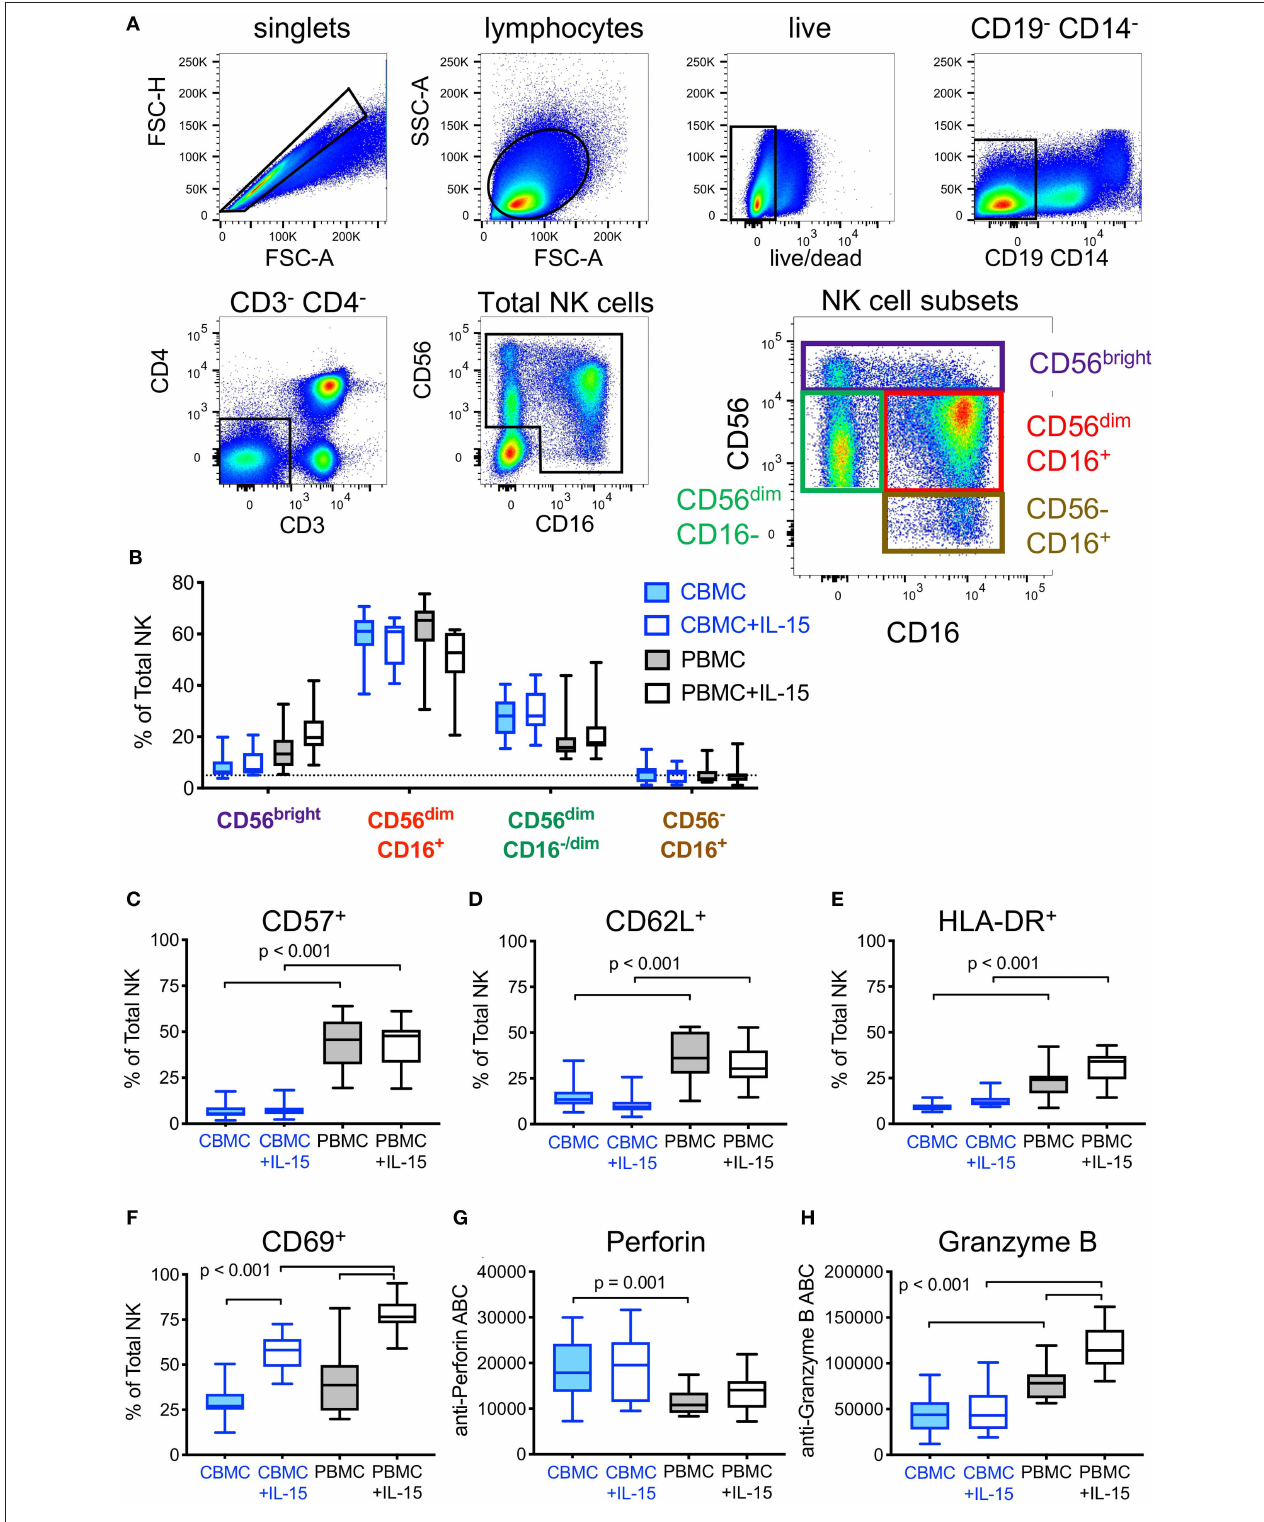
FIGURE 6 | Effect of exogenous IL-15 treatment on phenotypes of natural killer (NK) cells present in cord blood mononuclear cells (CBMC) with comparison to adult peripheral blood (PBMC). (A) Gating strategy used to identify total and subsets of NK cells. Data representing all CBMC samples ( n = 30, 15 CBMC donors + /- IL-15)